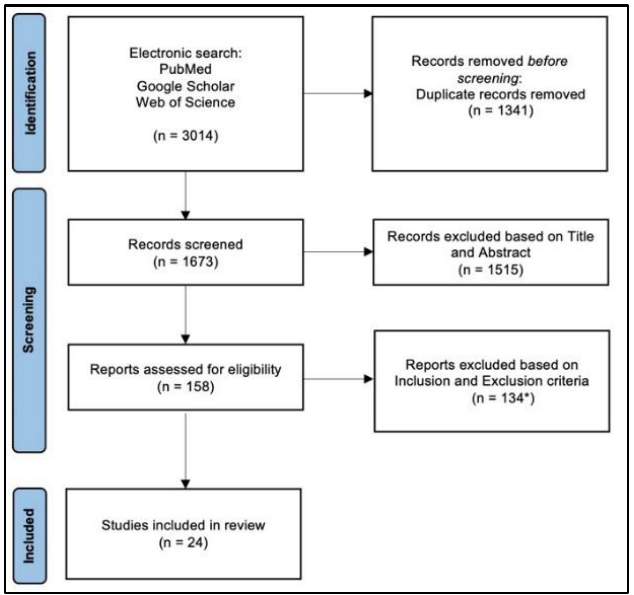
Figure 1. PRISMA flow-chart. (* 43 = studies on femoral NUs in segments other than the shaft, 39 = studies without surgical data, 37 = studies on septic NUs, 15 = studies on animal models). Out of 24 selected studies, 21 were retrospective [2,8,11,12,17,18,20–32,36,37] and 3 prospective [33–35] (Table